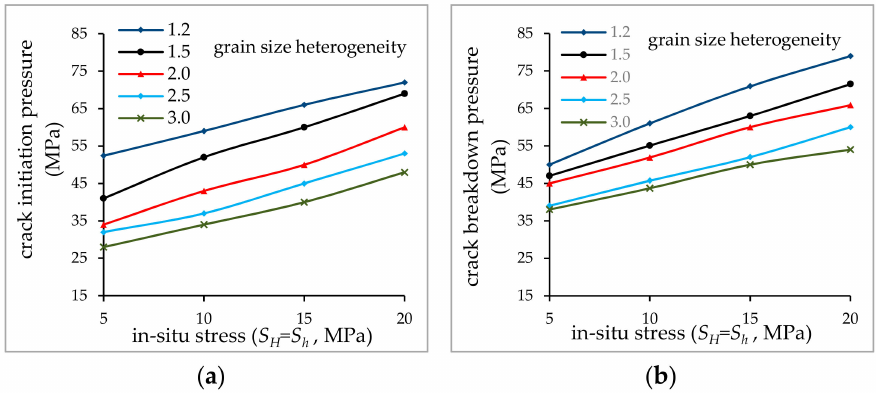
Figure 8. Effect of grain size heterogeneity on ( a ) initiation and ( b ) breakdown pressure under different in-situ